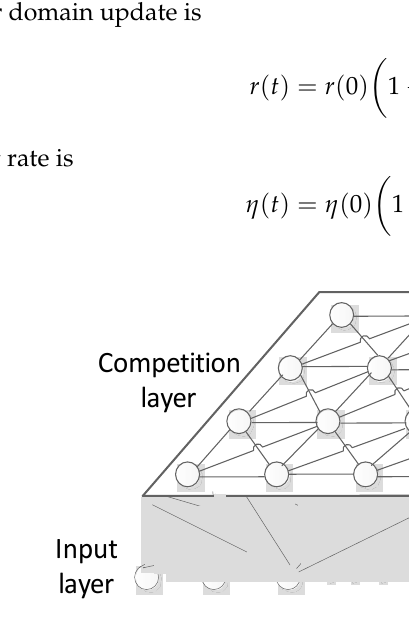
Figure 4. Topology of the self-organizing neural network.